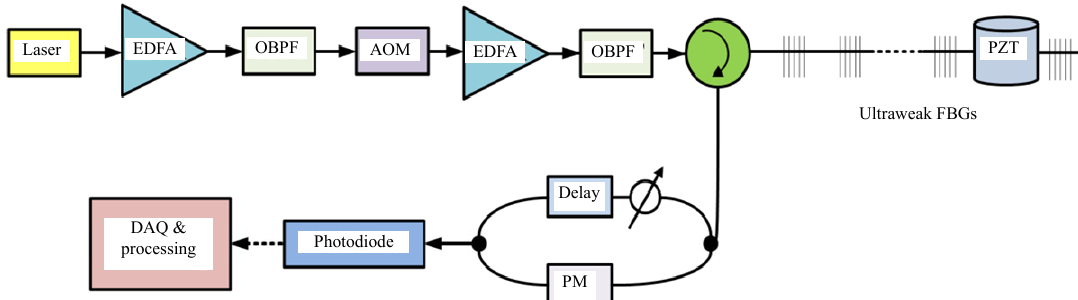
Fig. 14 Schematic of the system based on UWFBG array and PGC-DCM algorithm [57]